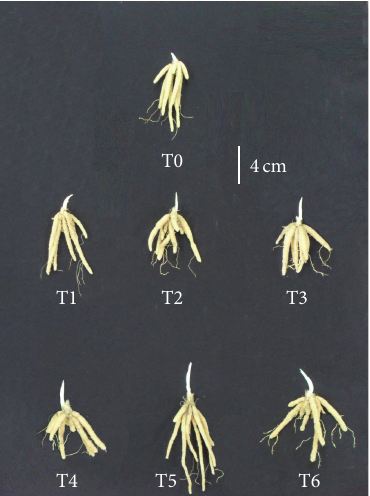
Figure 1: The elongation of sprout and root at 28 DAS as affected by different treatments. Tubers treated with T3 and T6 had the longest root length among all treatments. The longest sprout length was recordedfromtreatmentT5.Note:T0=control;T1=10 mg L −1 GA 3 ; T2=15mgL −1 GA 3 ;T3=20mgL −1 GA 3 ;T4=5%HA;T5=10%HA; T6 = 15%